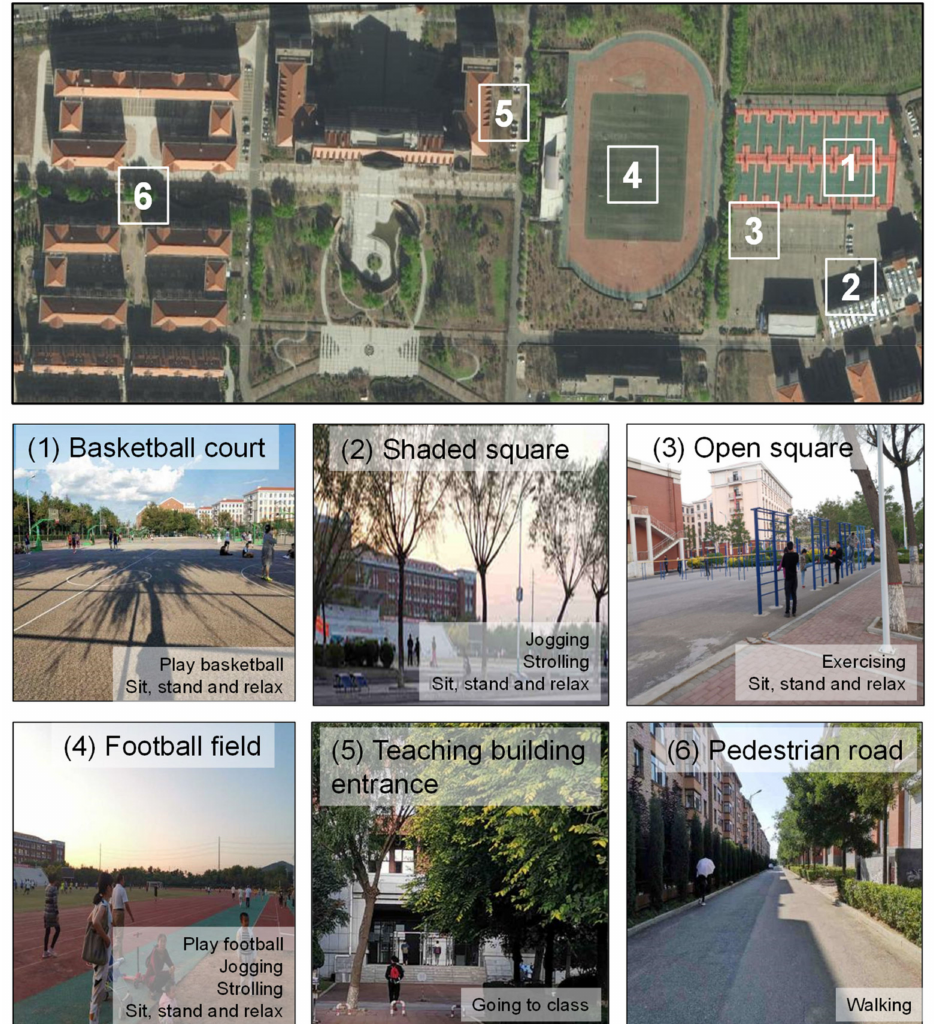
Figure 2. Selected places of study and corresponding activities at each place: ( 1 ) Basketball court, ( 2 ) Shaded square, ( 3 ) Open square, ( 4 ) Football field, ( 5 ) Teaching building entrance, and ( 6 ) Pedes- trian road.